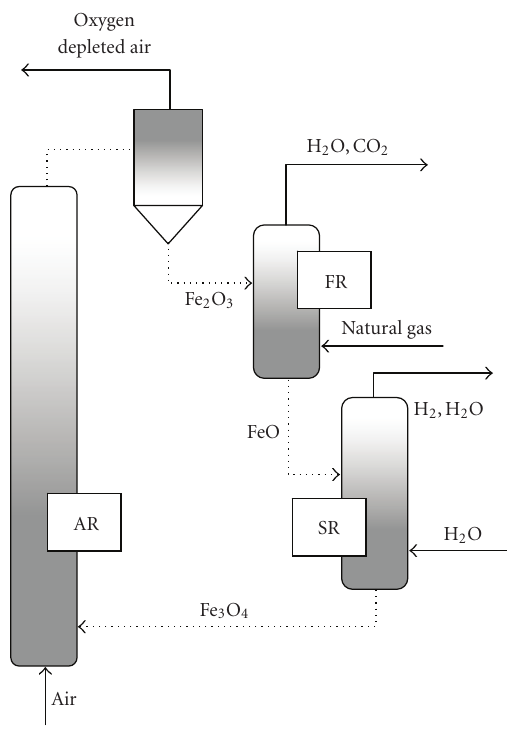
Figure 7: Conceptual scheme of the three-reactor CLH system. AR: air reactor; FR: fuel reactor, SR: steam